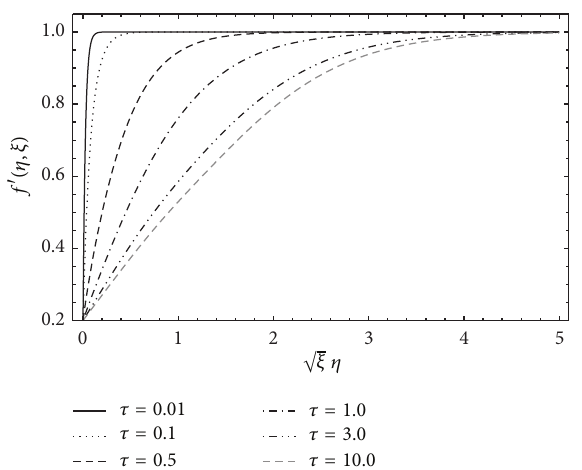
Figure 6: Velocity profile for different time 𝜏 when 𝛼 = 0.2, 𝜆 = 0.2 , and 𝛽 = 5 are kept